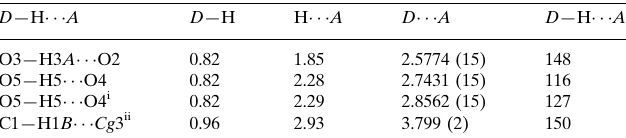
Hydrogen-bond geometry (A˚ , (cid:1)